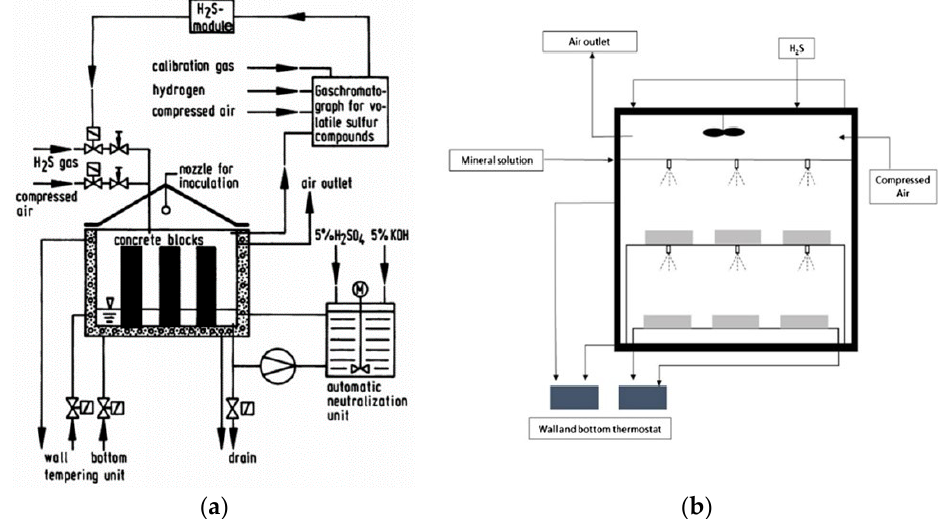
Figure 5. ( a ) Original Hamburg chamber [54] ; ( b ) Hamburg chamber modified by [53].